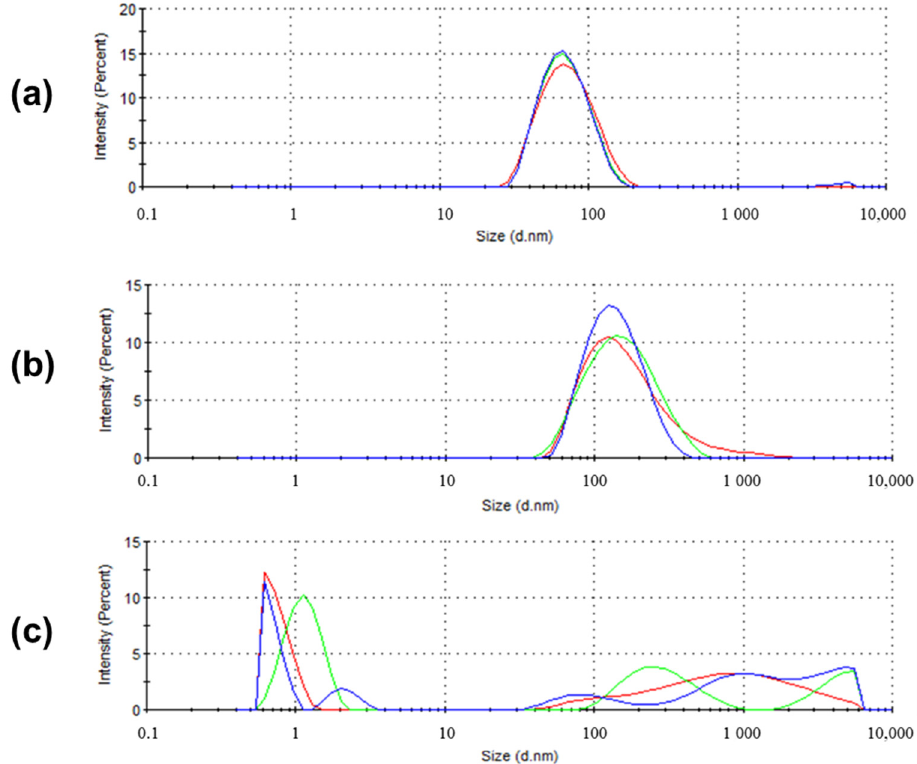
Figure 5. Size distribution by intensity of the particles from solutions of gelator B at different concentration: ( a ) 0.5 w / w ; ( b ) 1.0% w / w ; ( c ) 2.0% w / w .